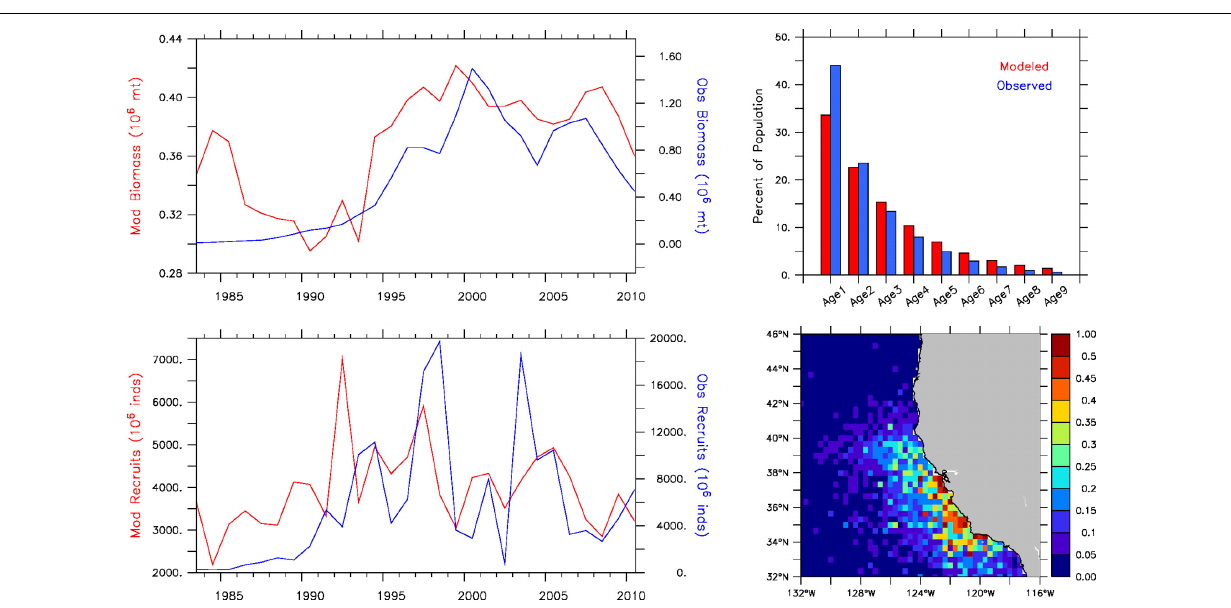
differ substantially between the GFDL, Hadley and IPSL